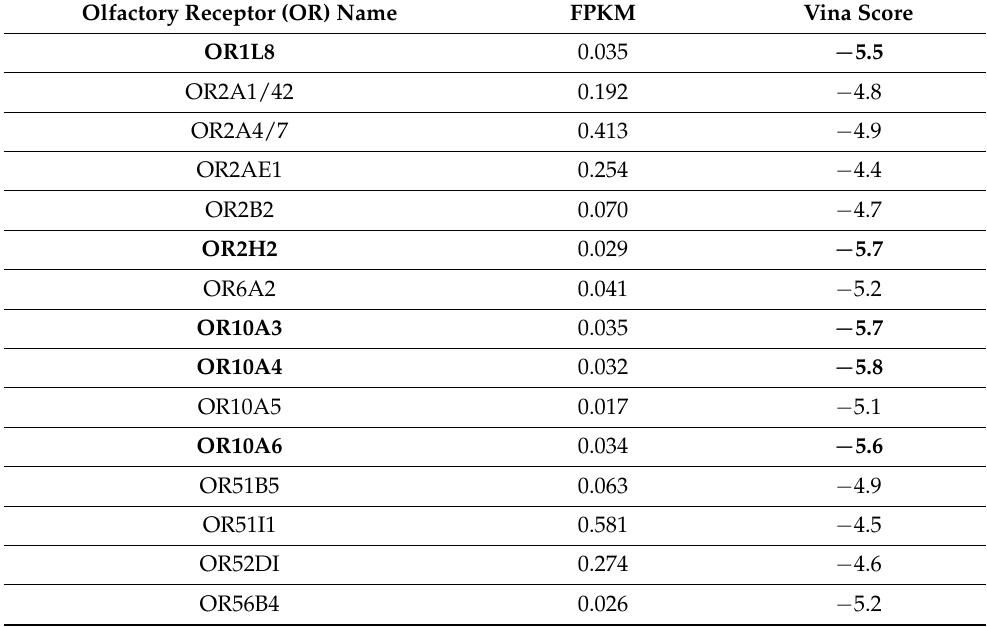
Table 3. The expression profiles (FPKM) of 15 candidates olfactory receptor (OR) genes detectable in Hs68 cells and virtual screening of suberic acid-ORs binding affinities using autodock vina